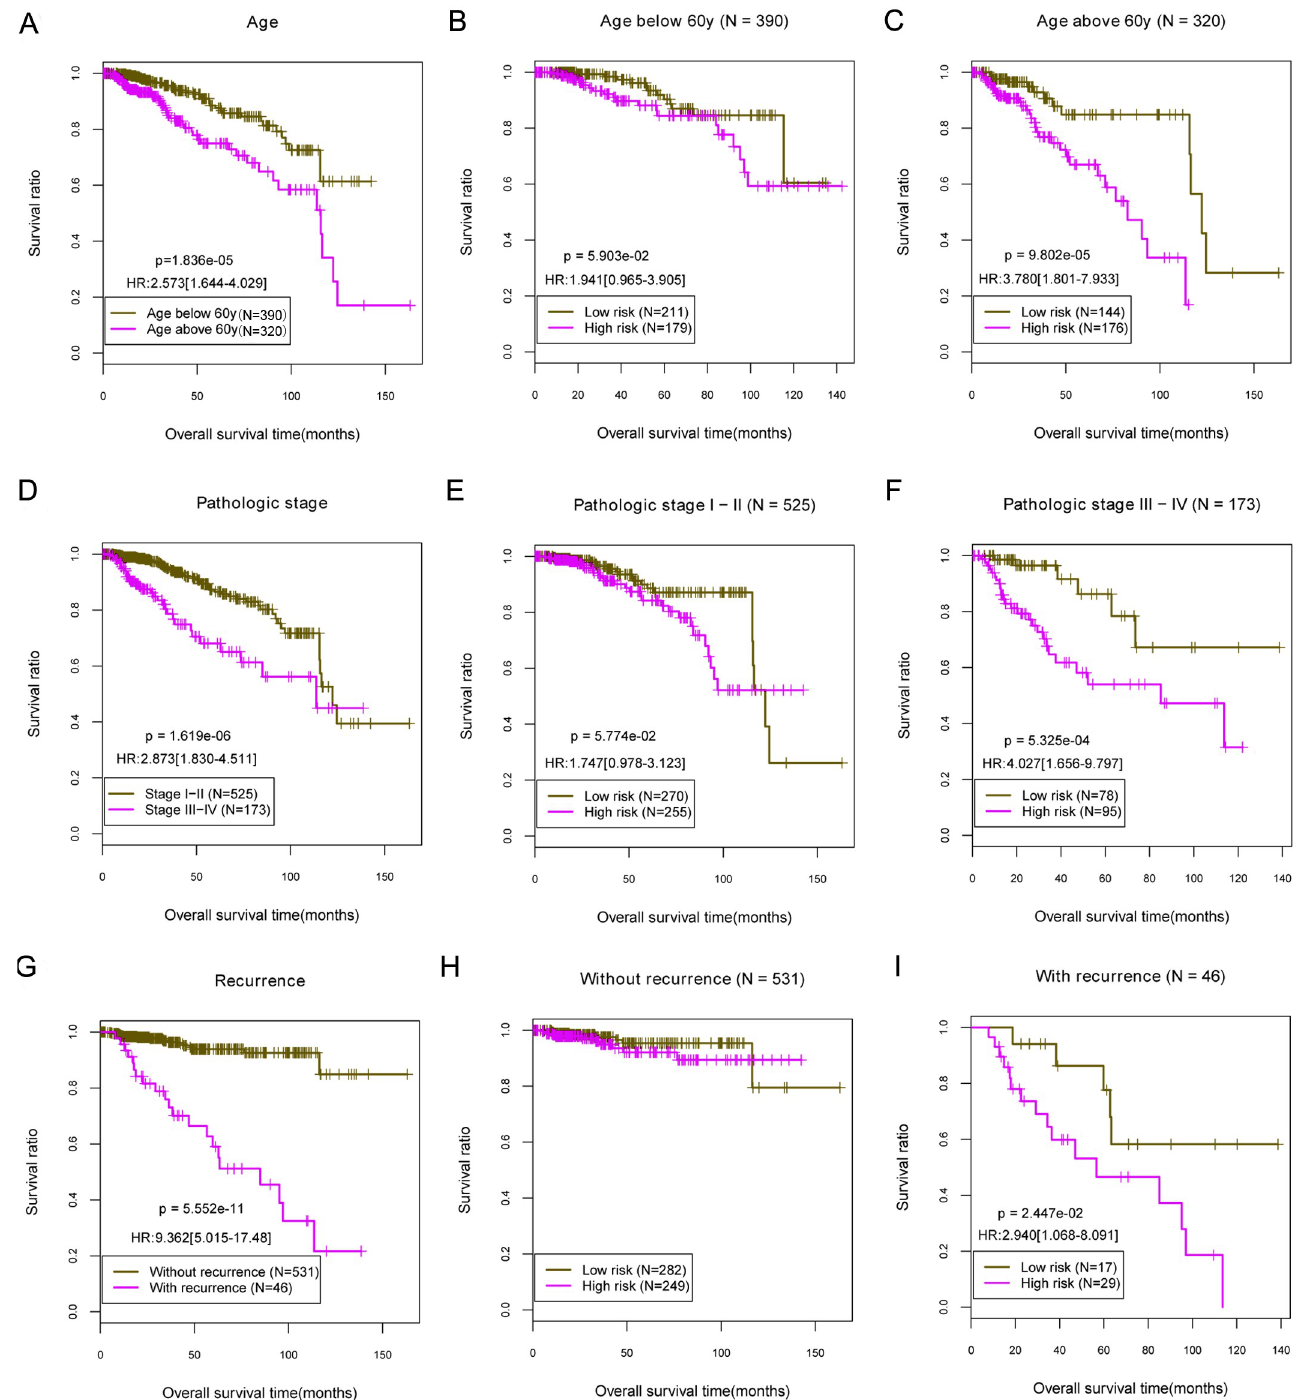
Fig 4. The prognostic-related Kaplan-Meier curve of age, pathologic stage, and tumor recurrence. (A) The prognostic-related Kaplan-Meier curve of age. (B, C) Patients aged over 60 and below 60 prognosis-related Kaplan-Meier curves in TCGA samples. (D) The prognostic-related Kaplan-Meier curve of pathologic stage. (E, F) Pathologic stage I-II and III-IV group in the TCGA sample prognosis-related Kaplan-Meier curve chart. (G) The prognostic-related Kaplan-Meier curve of recurrence. (H, I) Samples of the group with and without recurrence based on the prognostic prediction model Kaplan-Meier curve diagrams. TCGA, The Cancer Genome